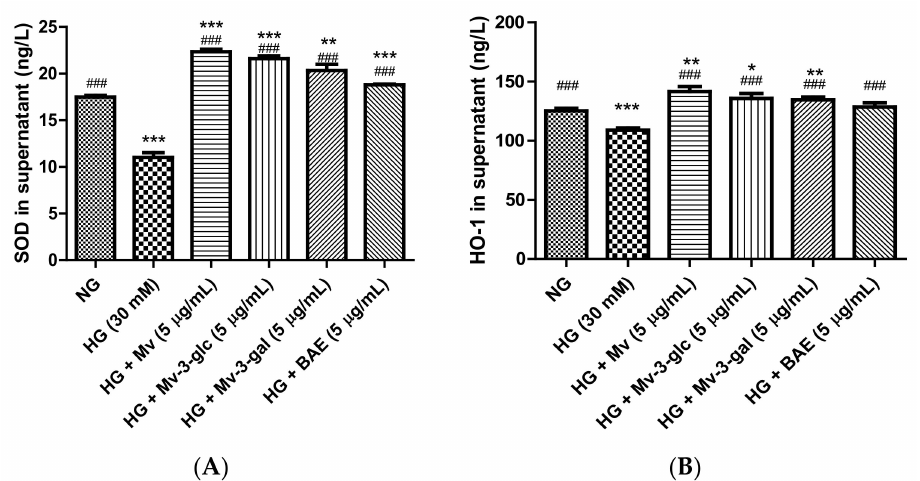
Figure 3. E ff ects of Mv, Mv-3-glc, Mv-3-gal, and BAE on antioxidant ( A ) superoxide dismutase (SOD) and ( B ) heme oxygenase-1 (HO-1) production released into the supernatant of HUVECs exposed to high glucose for 24 h. Bars represent mean values ± SD ( n = 3). *, **, and *** indicate p < 0.05, p < 0.01, and p < 0.001, respectively, compared with the control NG; ### indicates p < 0.001 compared with the HG